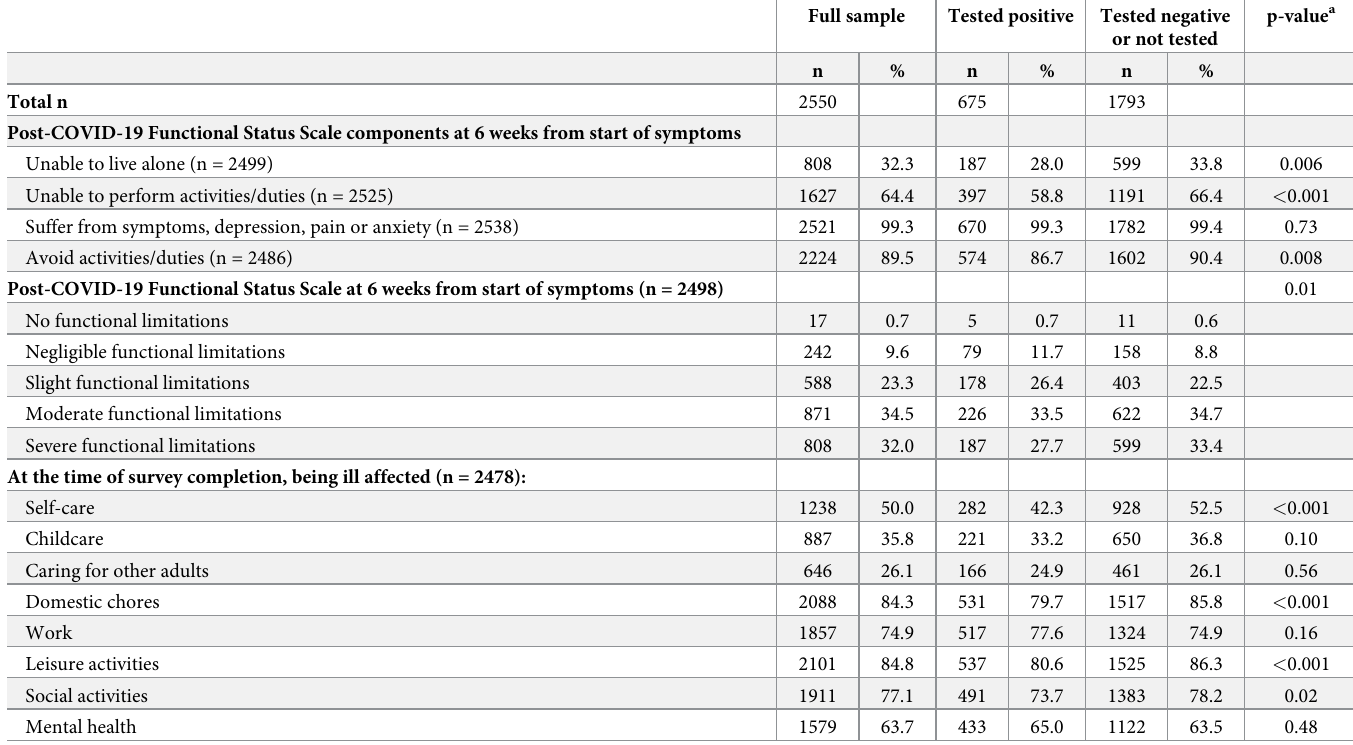
Table 5. Functional ability of study